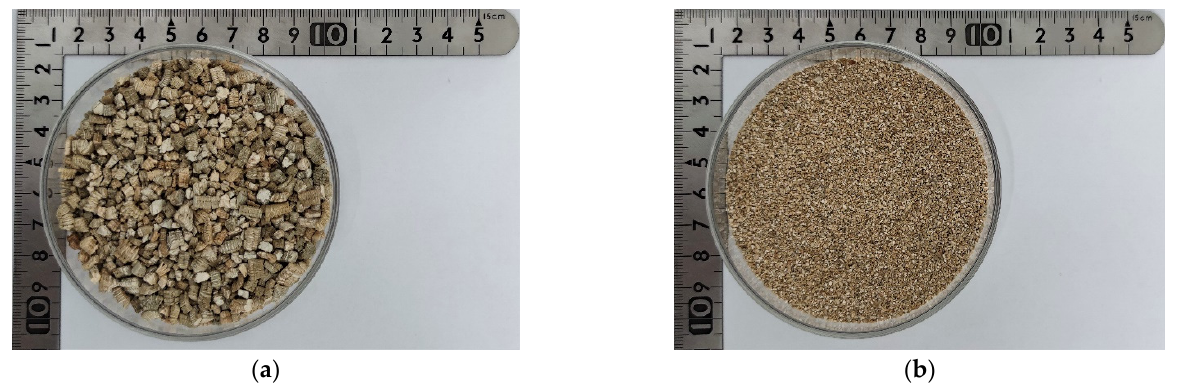
Figure 1. The appearance of the EVM. ( a ) E1 (3~6 mm); ( b ) E2 (0.4~0.8 mm). Mercury intrusion porosimetry (MIP, AutoPore IV 9500) is used to measure the EVM of two particle sizes to obtain EVM porosity, pore size and other parameters. Take about 0.05 g of the EVM sample dried at a high temperature into the dilatometer, seal and weigh it. The experimental pressure range is 3.58~2.27 × 10 5 kPa, and the data are collected and analyzed.